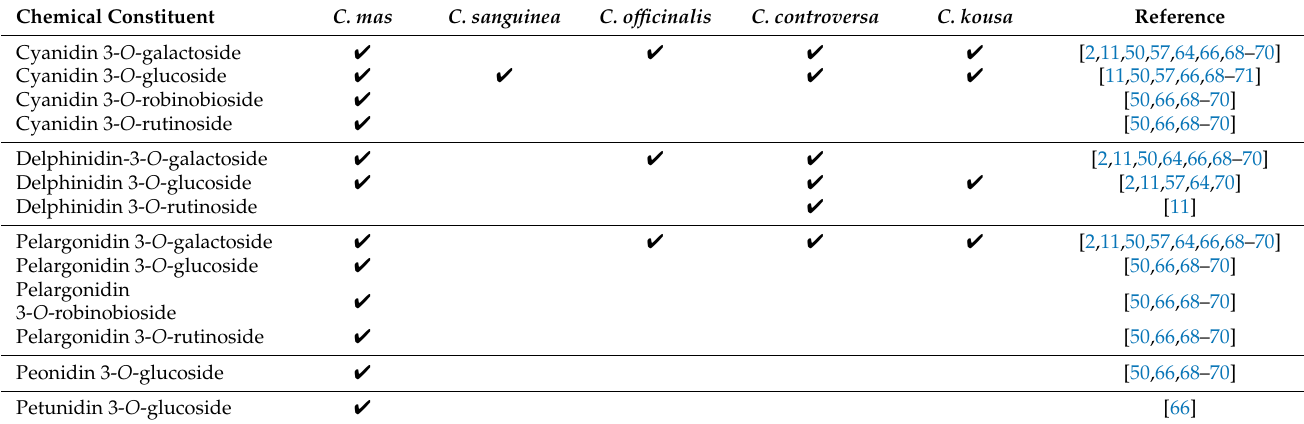
Table 3. The main anthocyanins are identified in Cornus fruits.